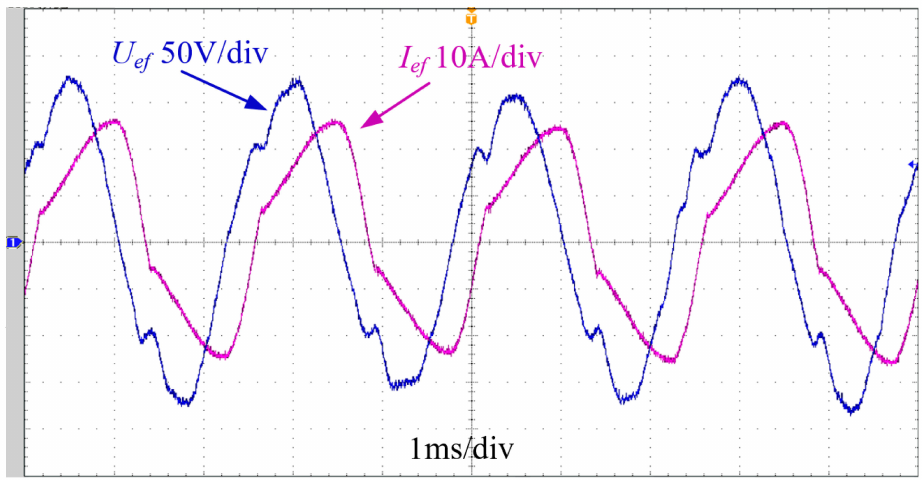
Figure 20. The waveform of AC excitation voltage U ef and current I ef .